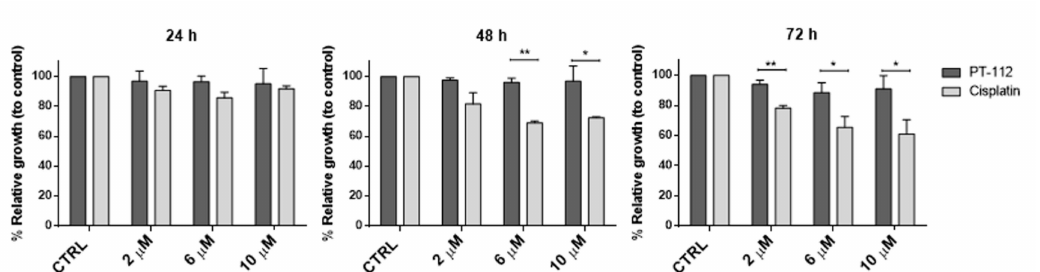
Figure 8. Cell growth analysis after treatment of L929- ρ 0 cells with PT-112 or cisplatin. Cells were treated with increasing concentrations of PT-112 or cisplatin, incubated for 24–72 h, and relative growth was measured by MTT assay. Results correspond to the percentage of relative growth compared to untreated, control cells (CTRL). Results are shown as mean ± SD of at least 2 independent experiments performed in duplicate. * p < 0.05, ** p <